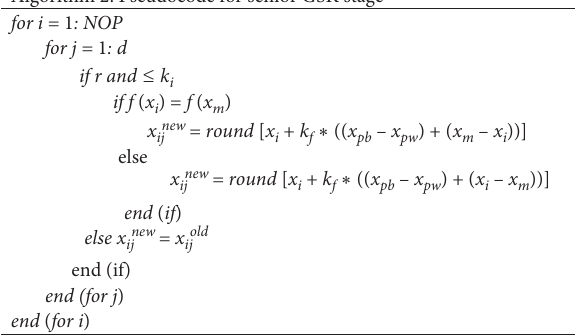
Figure 4: Pseudocode for senior GSK